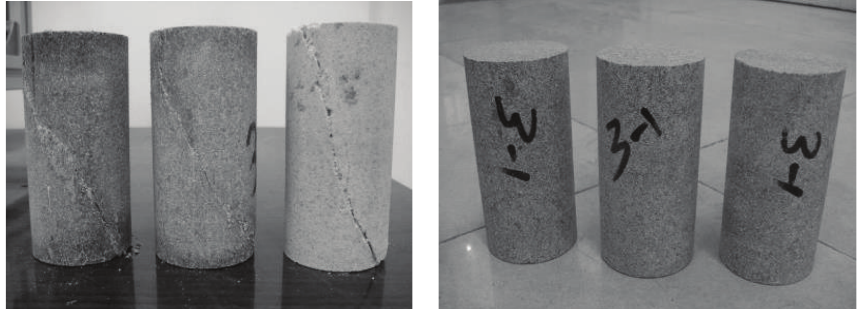
Figure 5: Intact and cracked quartz sandstone samples.